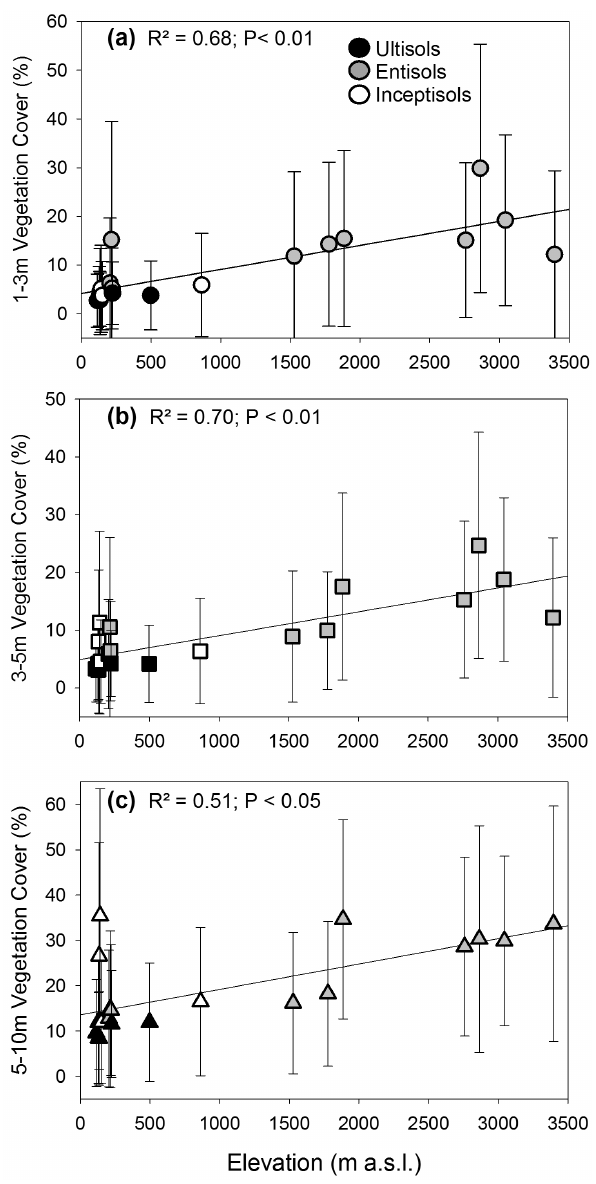
Fig. 6. Changes in mean understory canopy cover along the eleva- tion gradient in (a) 1–3m, (b) 3–5m, and (c) 5–10m height classes from Fig. 5. Error bars indicate standard deviation of canopy cover in each 25ha forest landscape. Symbols are colored by USDA soil order.